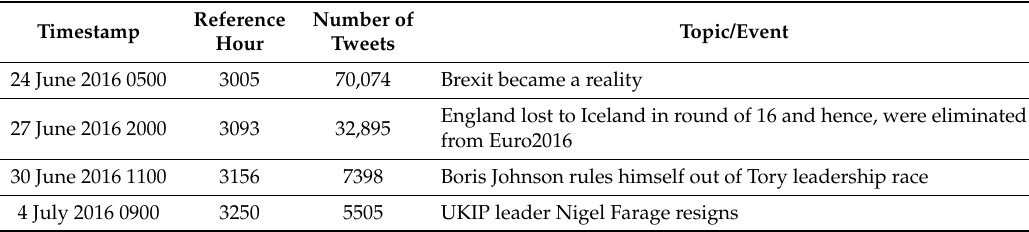
Table 9. Peaks and Corresponding Events.